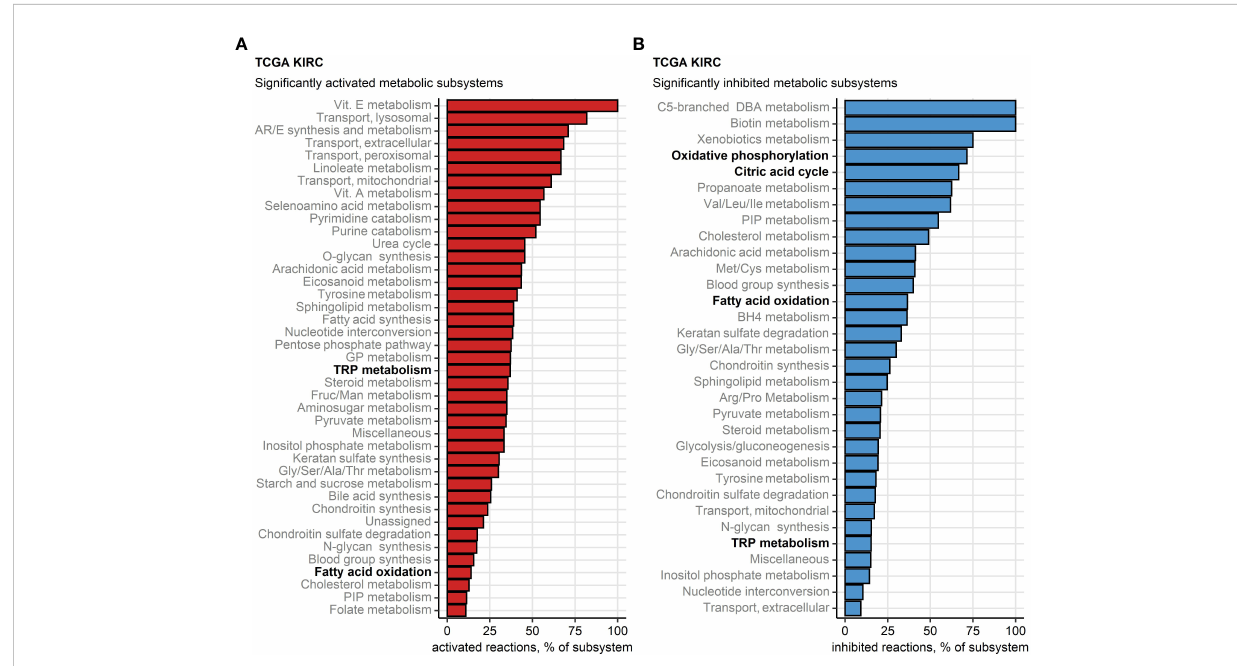
FIGURE 9 Differential regulation of metabolic reactions between the two chemokine clusters. Regulation of the Recon human metabolism model reactions in chemokine (chemox) high versus chemokine low cluster cancers was predicted based on the differential gene expression with the BiGGR and biggrExtra package tools. Signi fi cance of the metabolic reaction regulation was assessed by Monte Carlo simulation and corrected for multiple testing with the false discovery rate (FDR) method. Fractions of signi fi cantly activated (A) and signi fi cantly inhibited (B) reactions within the Recon model subsystems are presented for the TCGA KIRC cohort. Fatty acid oxidation, citric acid cycle, oxidative phosphorylation and tryptophan (TRP) metabolism subsystems investigated in more detail are highlighted in